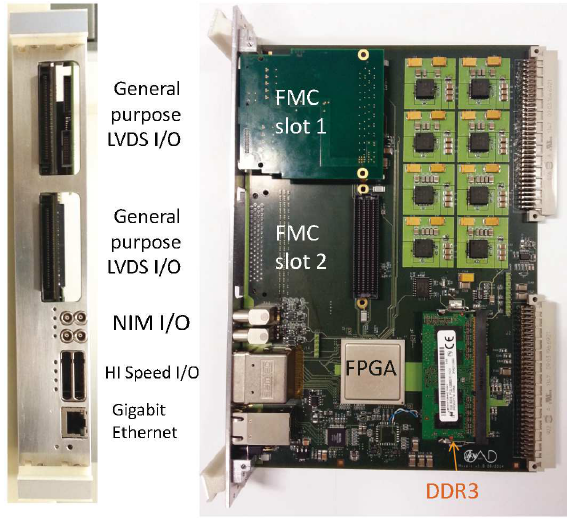
Figure 1. The MOSAIC board